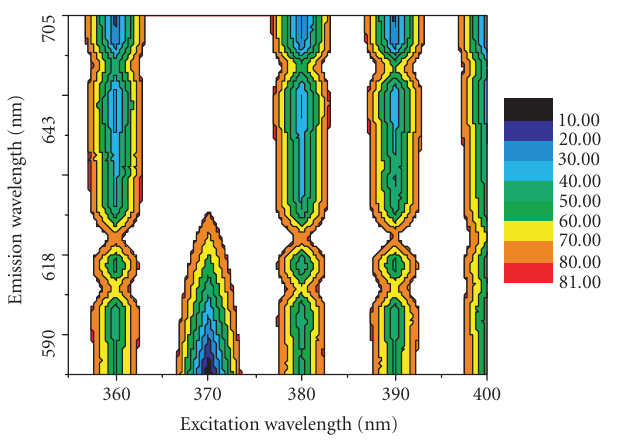
Figure 9: Contour view of the emission spectra of Eu 3+ ion in MC- Eu complex at di ff erent excitation wavelengths in DMSO.